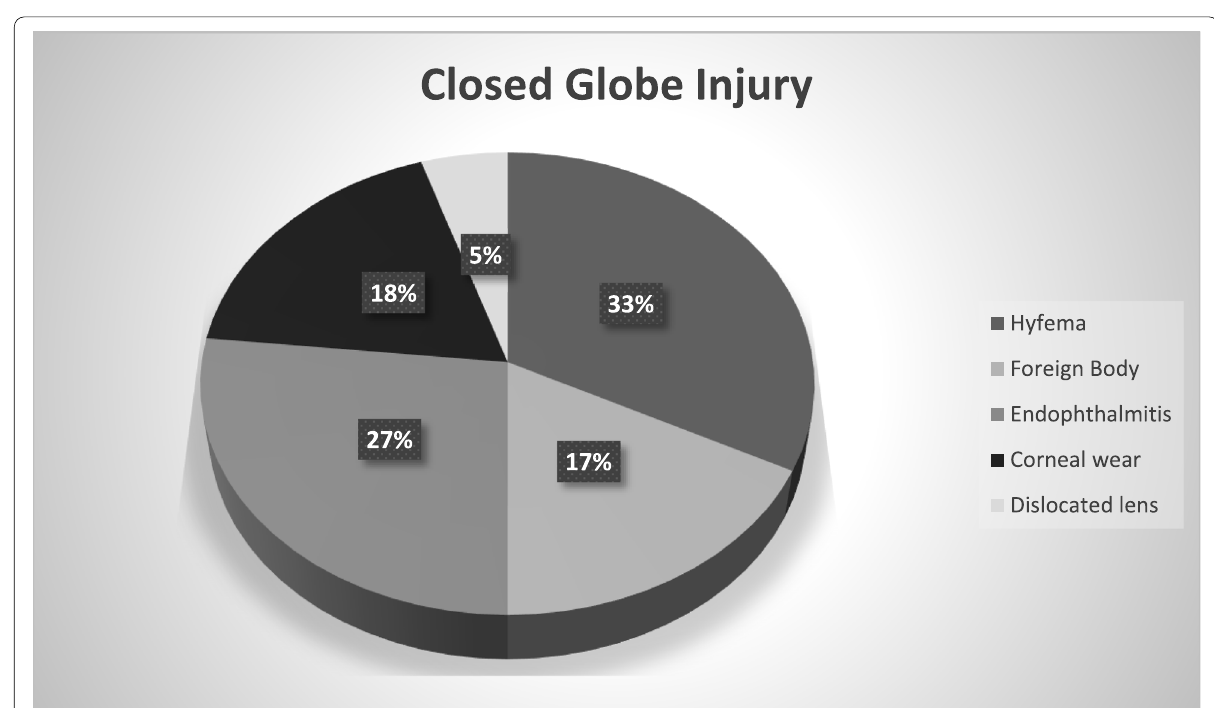
Fig. 1 Types of closed globe